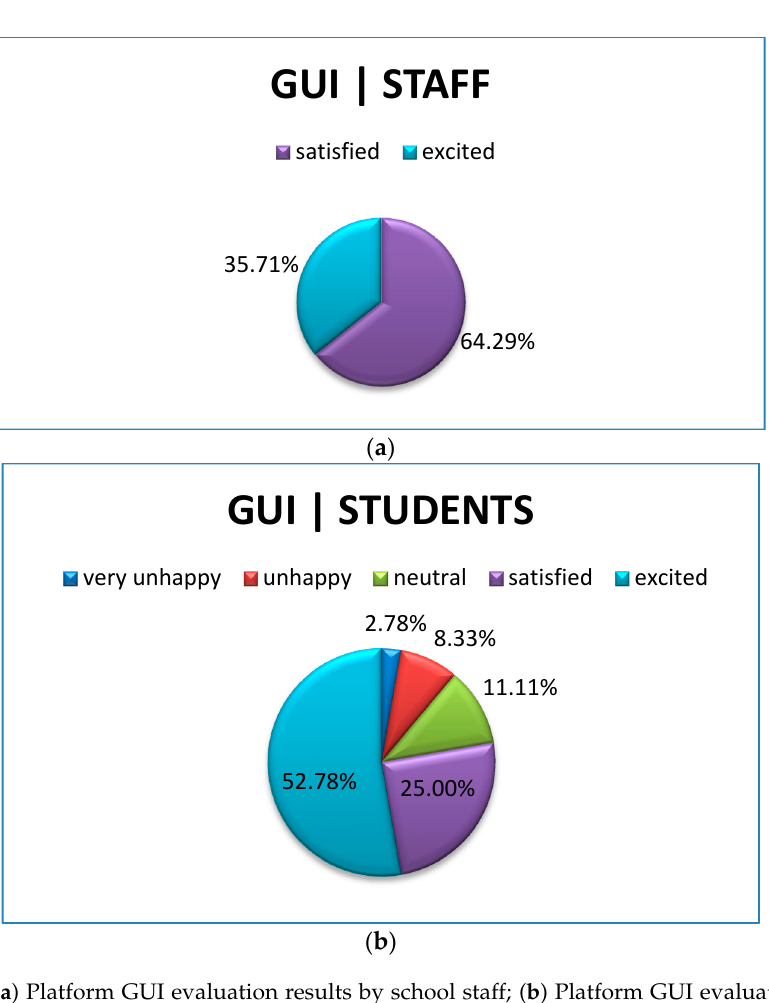
Figure 17. ( a ) Platform GUI evaluation results by school staff; ( b ) Platform GUI evaluation results by student.